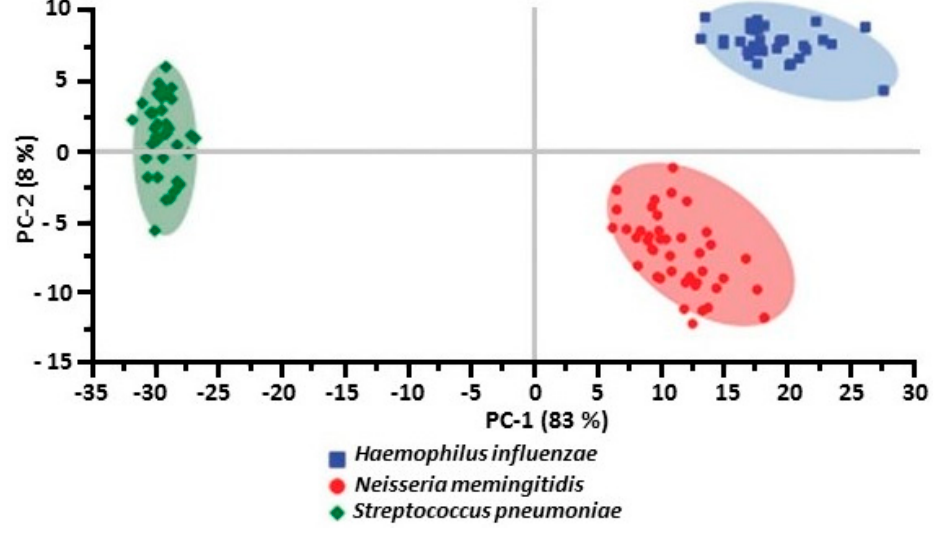
Figure 16. The comparison of the calculated PCA analysis for three bacteria: S. pneumoniae (green diamonds), H. influenzae (blue squares), and N. meningitidis (red circles) [51]. Reproduced with permission from the Royal Society of Chemistry.